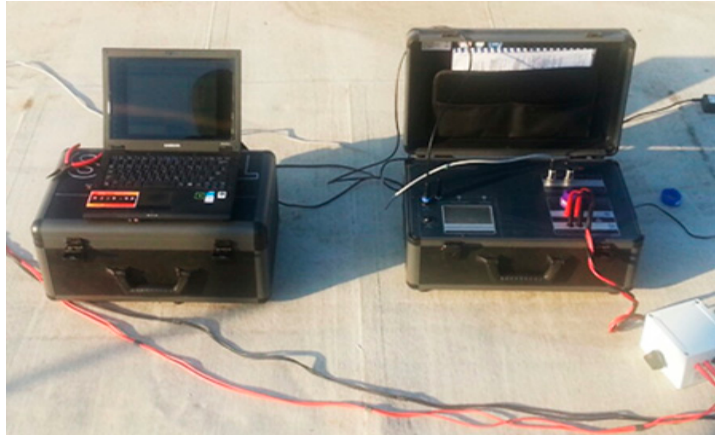
Figure 9. Measurement tools using IV-Checker (Gossen Metrawatt, Nuremberg, Germany). Appl. Sci. 2018 , 8 , x FOR PEER REVIEW